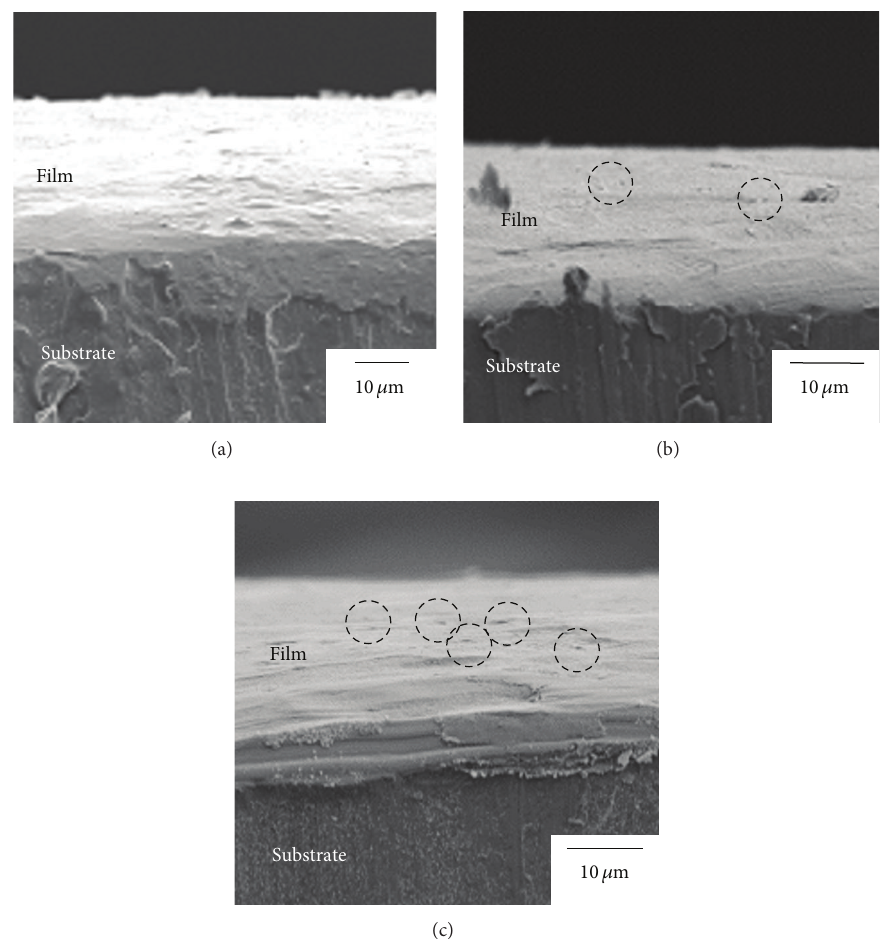
Figure 3: Cross-sectional SEM images of films deposited at various Y 2 O 3 concentrations in a suspension solution (0.5, 2.0, and 5.0 wt%), with bias voltage of 0.5 V and bias frequency of 1kHz.